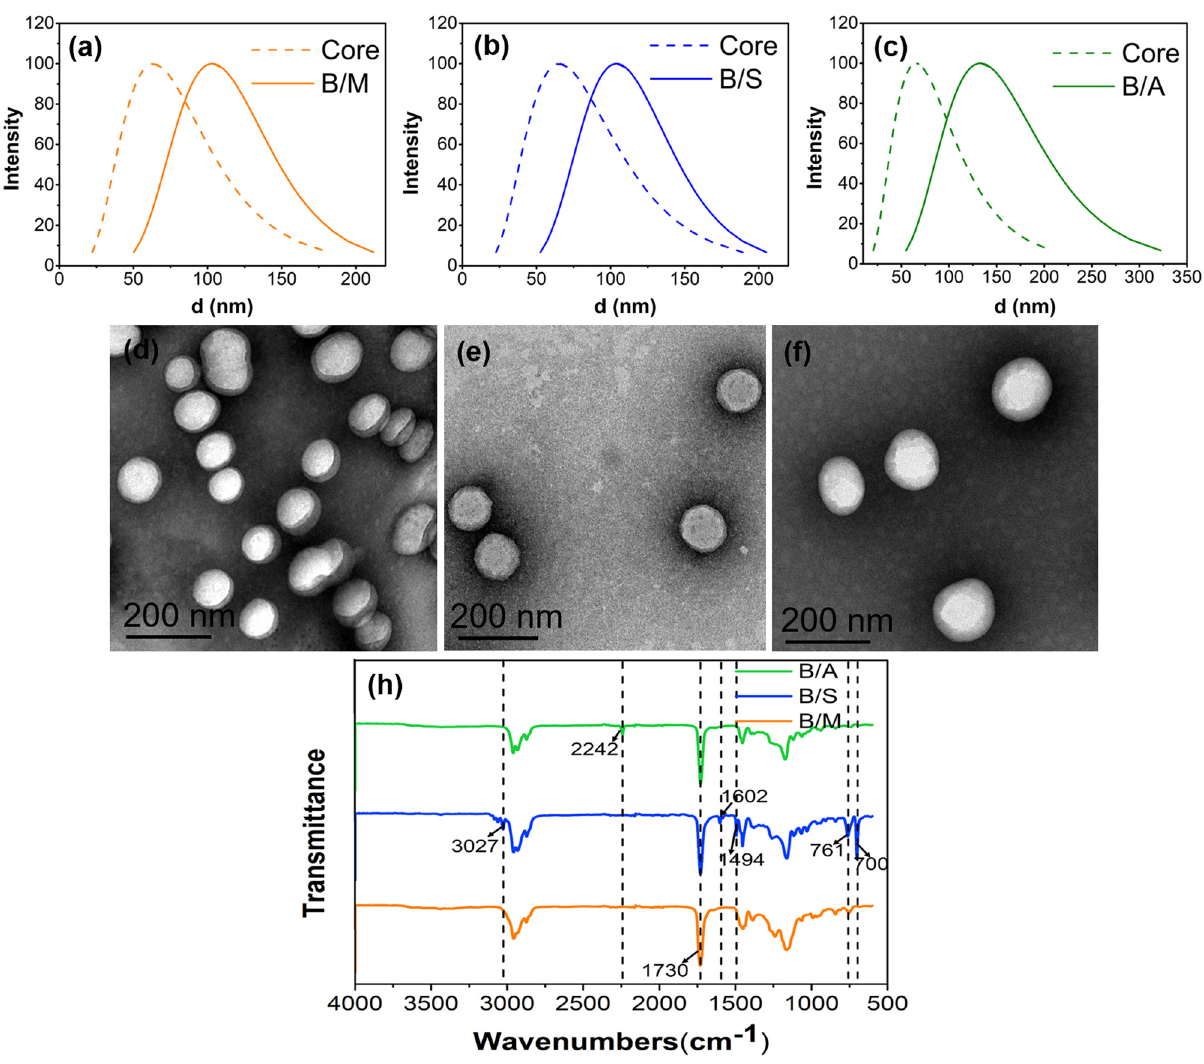
Figure 1: Core/shell nanoparticle characterization. Size distributions: ( a ) B/M, ( b ) B/S, ( c ) B/M. TEM images: ( d ) B/M, ( e ) B/S, ( f ) B/M, and FTIR spectra ( h )